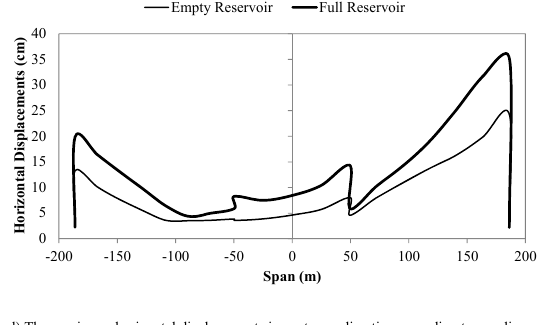
c) The maximum horizontal displacements in downstream direction according to non-linear analysis.